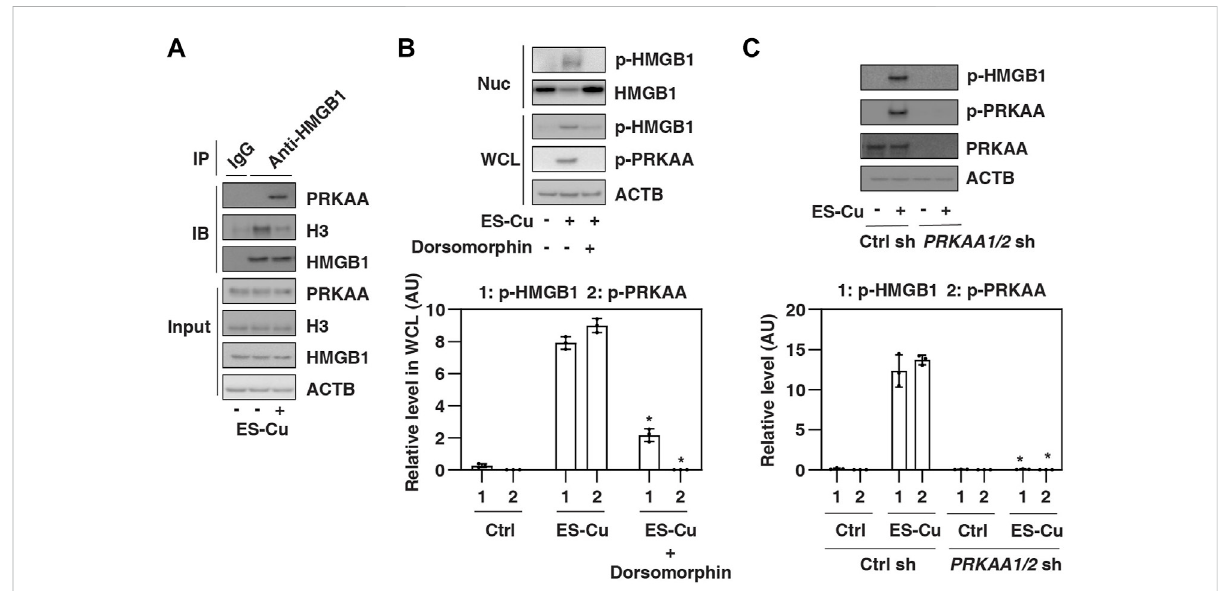
FIGURE 3 HMGB1 is phosphorylated by AMPK during cuproptosis. (A) IP analysis of the binding between HMGB1, PRKAA, and H3 in Calu1 cells following treatmentwithES-Cu(30nM/30 nM)for6 h(B,C)EffectsofdorsomorphinortheknockdownofPRKAAonphosphorylationofHMGB1andPRKAAin Calu1 cells following treatment with ES-Cu (30 nM/30 nM) for 6 h. Protein semi-quanti fi cation is shown in the down panel ( n = 3; * p < 0.05 versus controlgroup, two-wayANOVA).WCL:wholecellextraction.Nuc:nuclearextraction.TheresultsinA-Carerepresentativeofthosefromthree independent